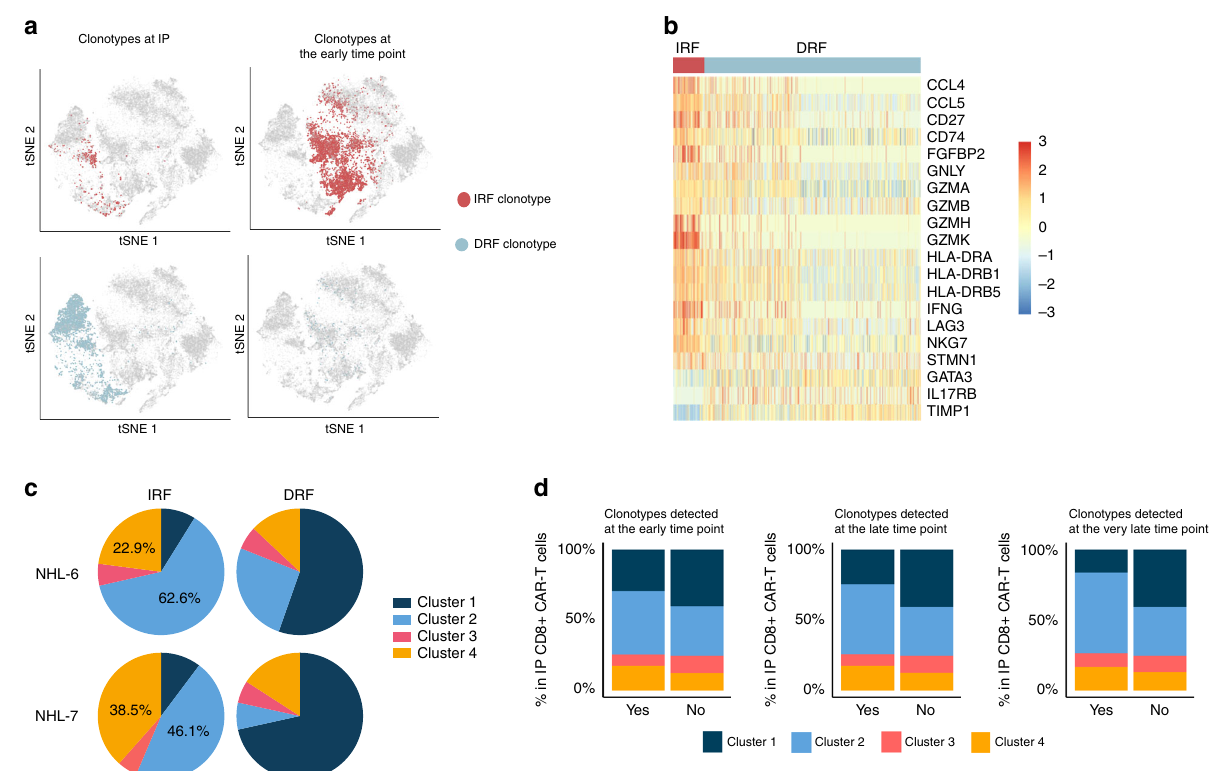
Fig. 7 Variable contribution of infused CAR-T clusters to in vivo repertoire. a t-SNE plot showing the localization of IRF clonotypes (red) and DRF clonotypes (blue) in the IP (left) or at the early time point (right). Each dot represents a single CAR-T cell. b Heatmap displaying genes that are differentially expressed between IRF and DRF clones in the IP. Color scale represents gene expression levels as a z -score. c Pie charts depict the fraction of IRF or DRF clonotypes that are distributed among the four transcriptionally distinct clusters in the IP. The percent of cells in cluster 2 and 4 among IRF clonotypes are reported. d Bars depict the fraction of transcriptionally distinct clusters among CD8 + CAR-T cells in the IP that were either detected (Yes) or not detected (No) at the early (Left), late (Middle), or very late (Right) time points after infusion. Source data are provided as a Source Data fi le. Table 1 The proportion of IRF and DRF clones that were present at the late and very late time points after